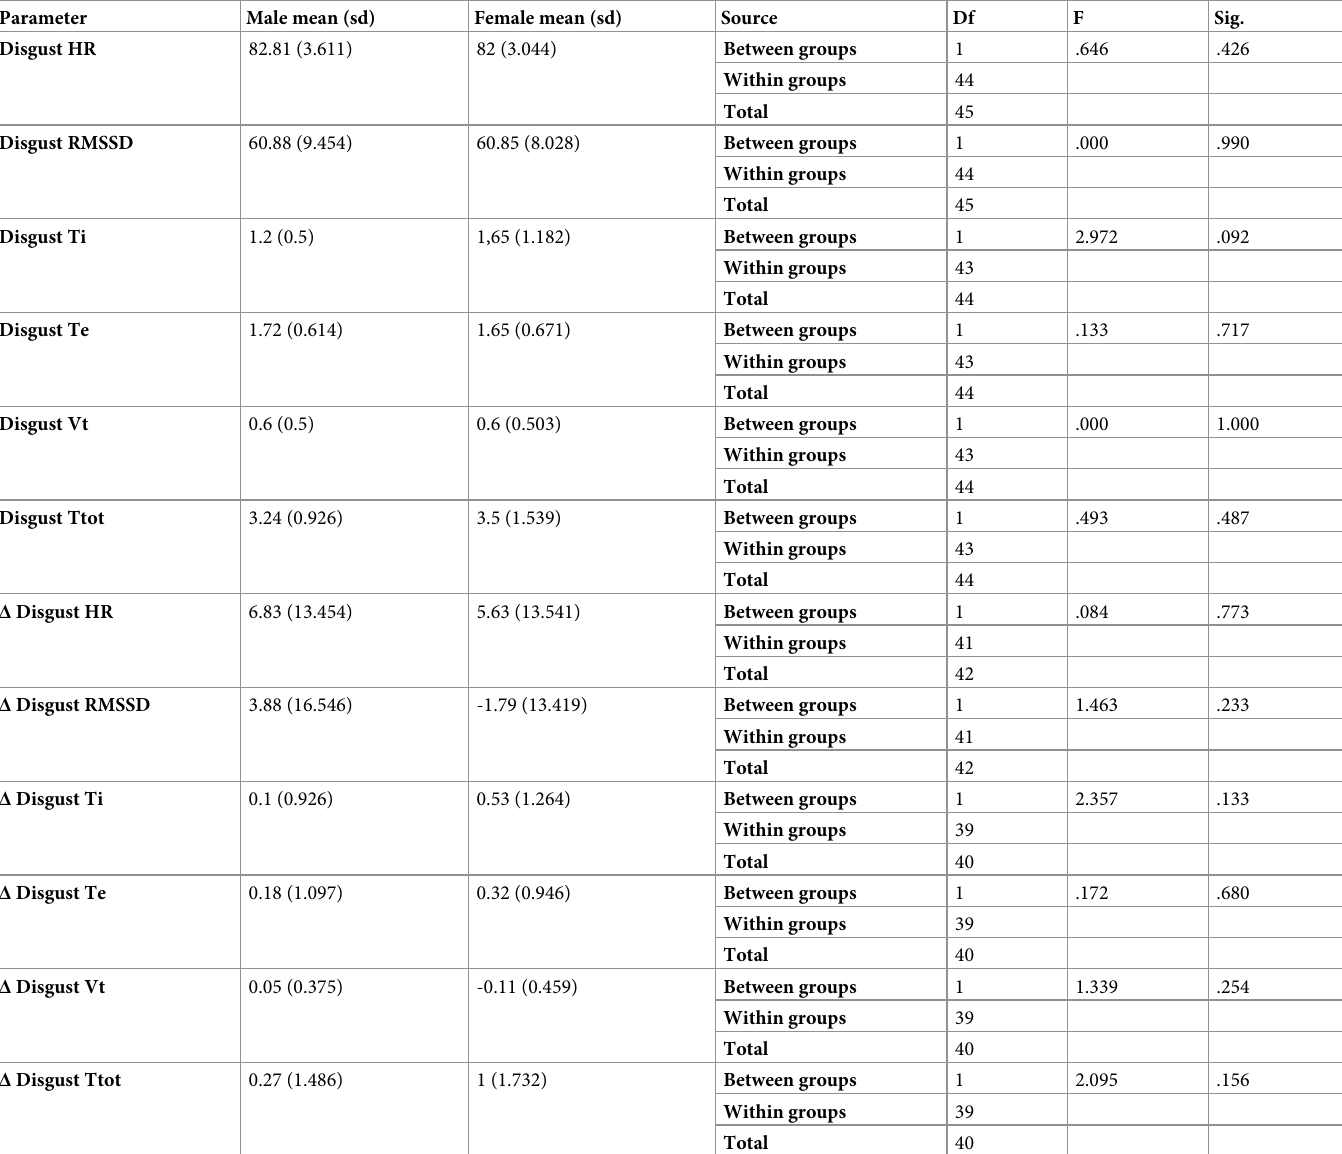
Table 5. ANOVA for autonomic (cardiac and respiratory) response and reactivity during disgust of males and females.